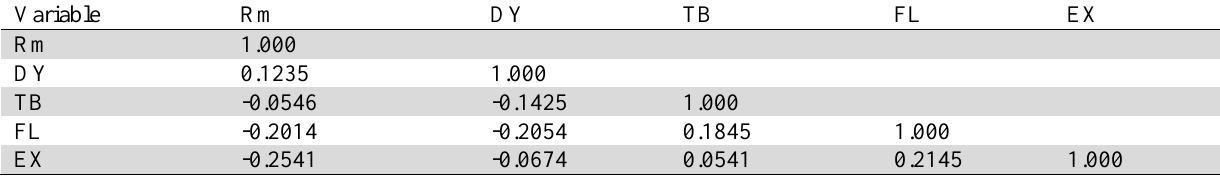
Test of Multicolinearity (Pearson Correlation matrix) Variable